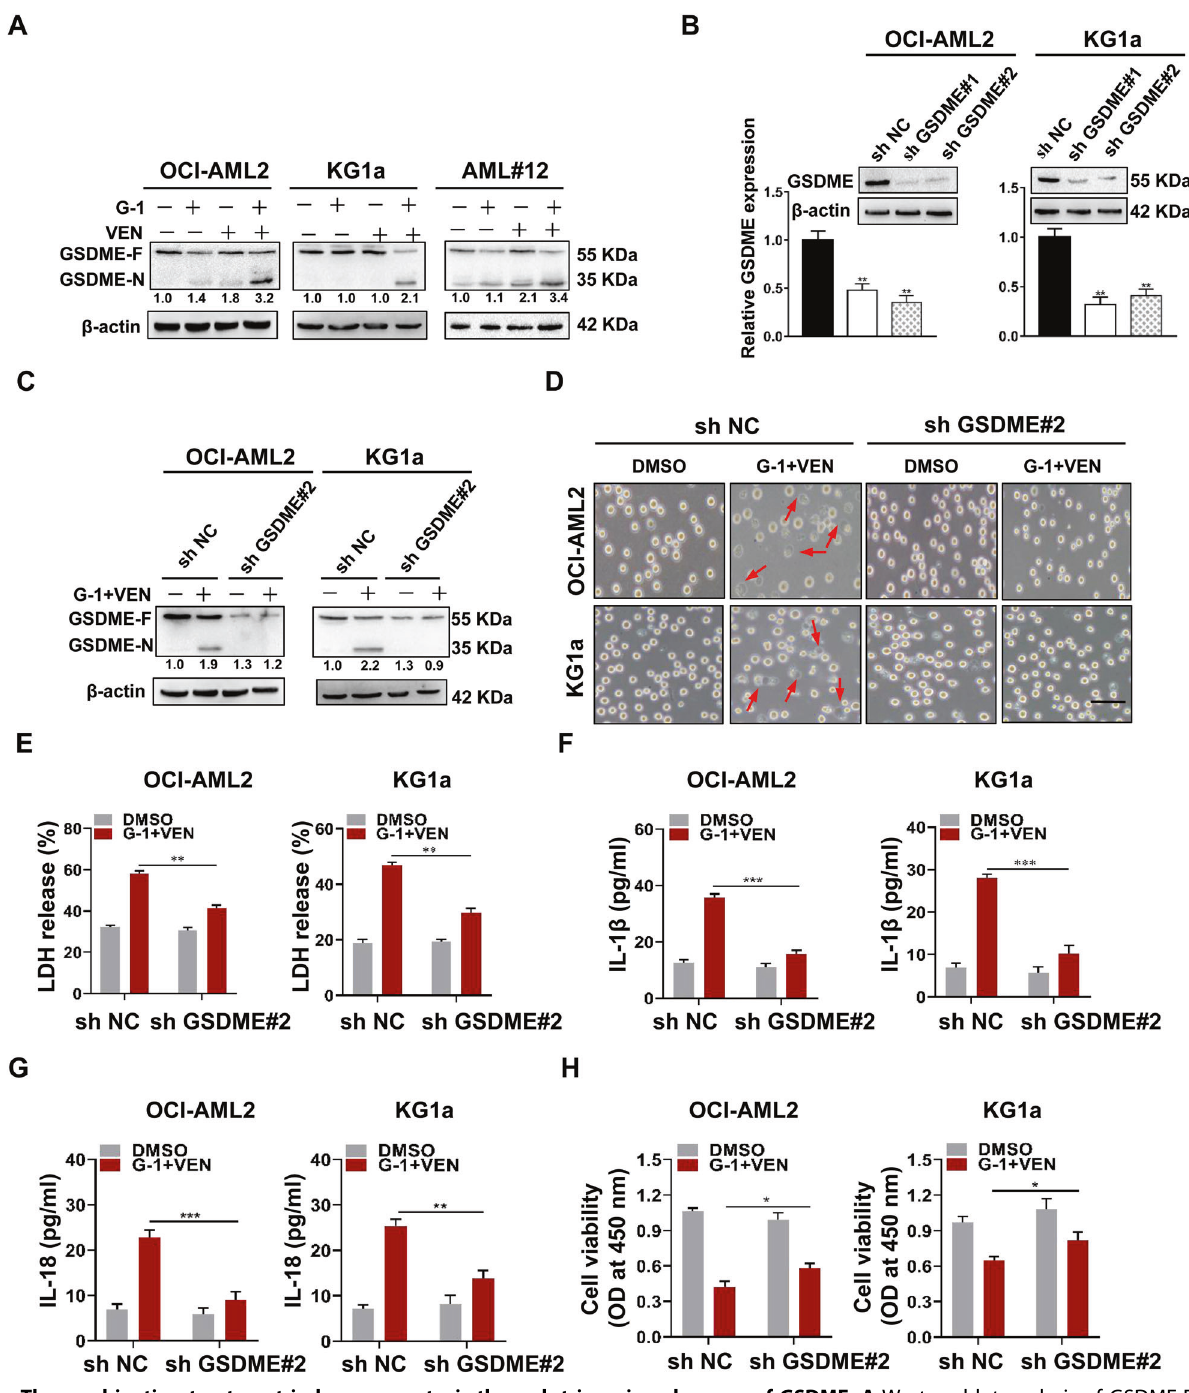
Fig. 6 The combination treatment induces pyroptosis through triggering cleavage of GSDME. A Western blot analysis of GSDME-F (full- length) and GSDME-N (N-terminal fragment) in the cell lines and primary blasts treated with G-1 and VEN alone or in combination for 24 h. B , C Western blotting of GSDME and GSDME-N in the cell lines infected with two independent sh RNA targeting GSDME, and then exposed to G-1 and VEN, alone or in combination for 24 h. D Representative light microscopy images of the leukemic cells (Scale bar: 50 μ m). E LDH assay of LDH level in supernatants from cell cultures. F , G ELISA assay of IL-1 β and IL-18 levels in supernatants from cell cultures. H CCK-8 assay of cell viability in the GSDME-silenced cells treated with the indicated drugs for 48 h. The data are expressed as the mean ± SD ( n = 3). * p < 0.05, ** p < 0.01; *** p <